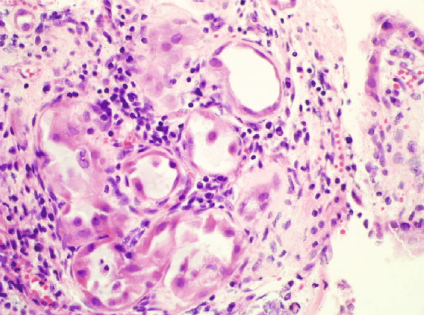
Figure 1: Photomicrograph of the NA in the urinary bladder at the time of second transplantation, showing tubular structures resembling renal medullary tubules.